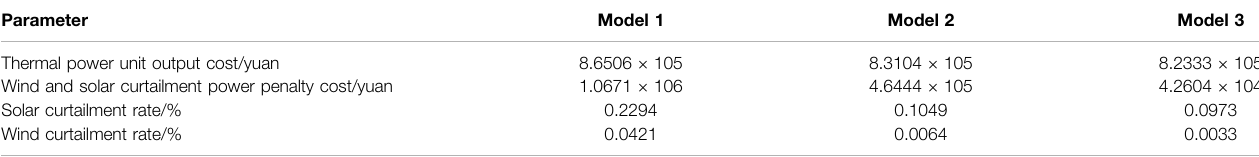
TABLE 3 | Comparison of costs under three